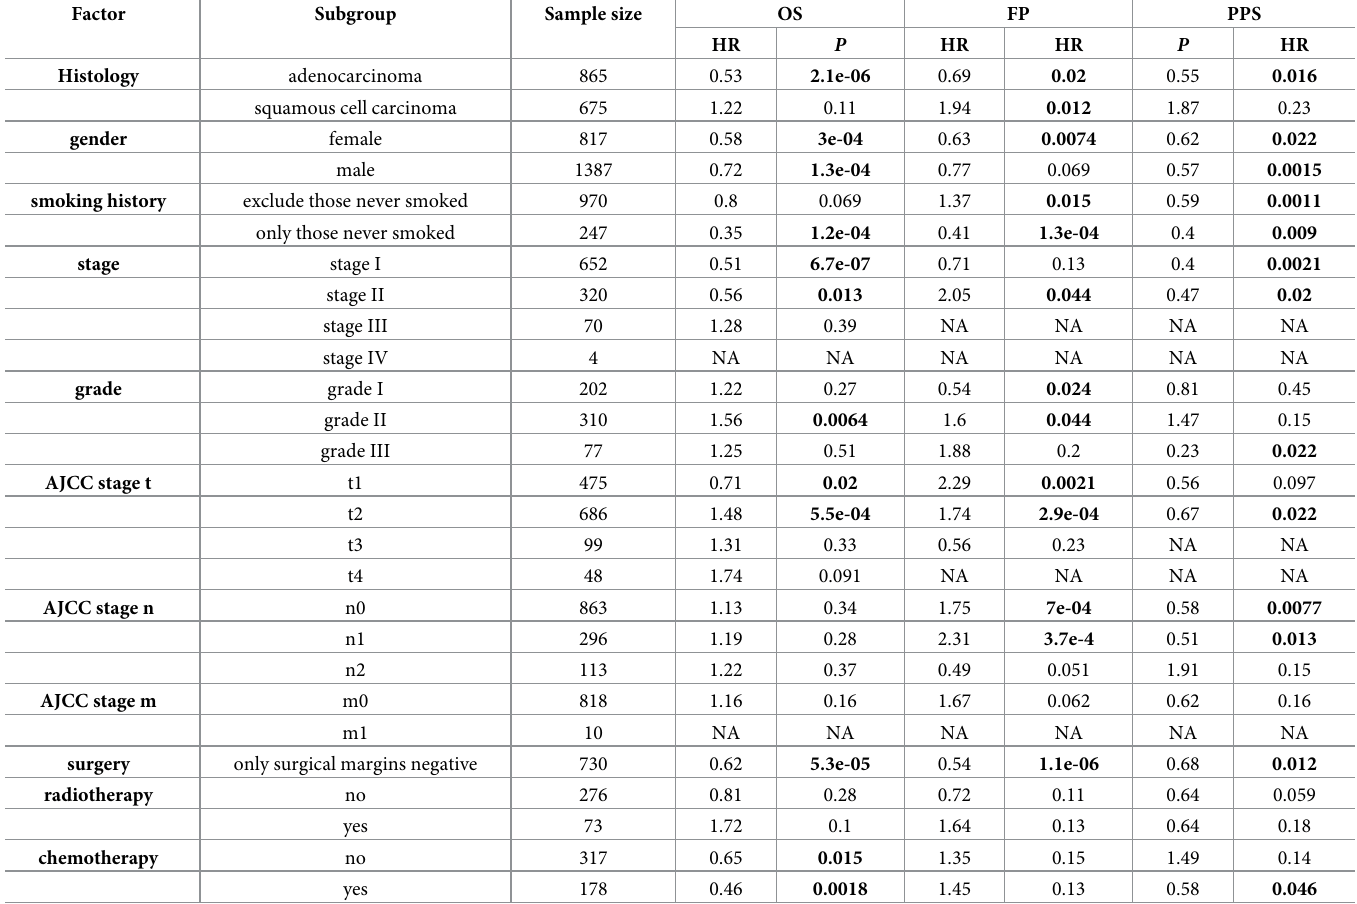
Table 3. Subgroup analysis on the correlation of SMARCA1 expression and prognosis of lung cancer